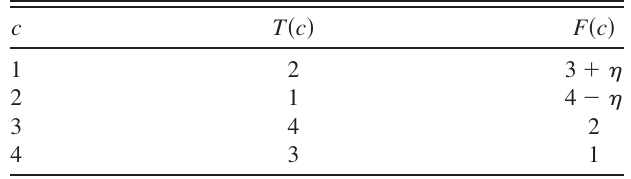
TABLE II. Transformation properties of the states shown in Table I. Here, it is assumed that the sector c refers to the original ! 0 limit. Translating zero-mode basis, defined through the L y the state with T would transition the state into sector T ð c Þ . After x dragging a quasihole along path a in Fig. 6 the state would transition from sector c into sector F ð c Þ , which is dependent on the particle number parity (cid:7)